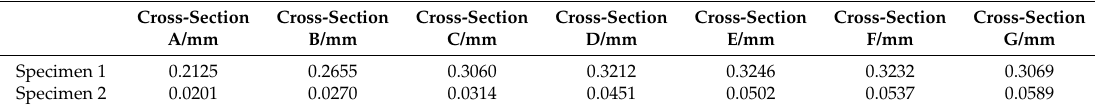
Table 3. Comparison of maximum deformation of cross-sections A–G for Specimens 1 and 2.